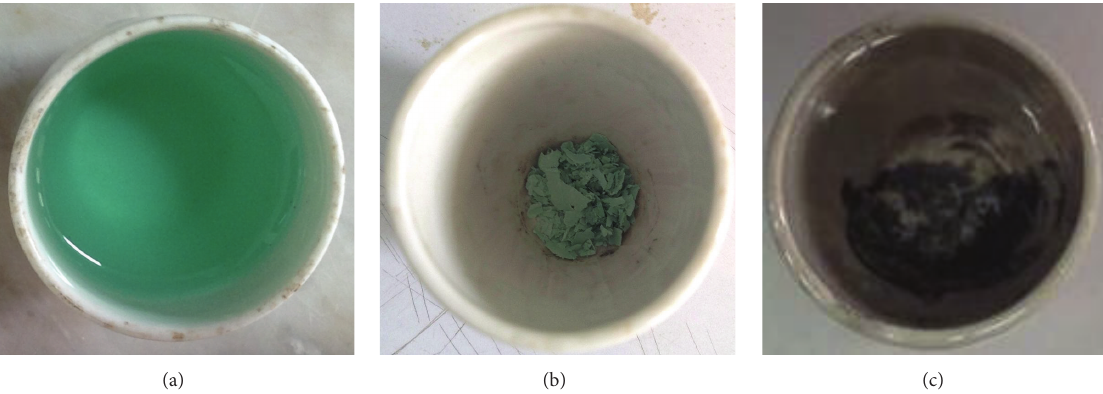
Figure 1: (a) Precursor; (b) nickel hydroxide; (c) nickel